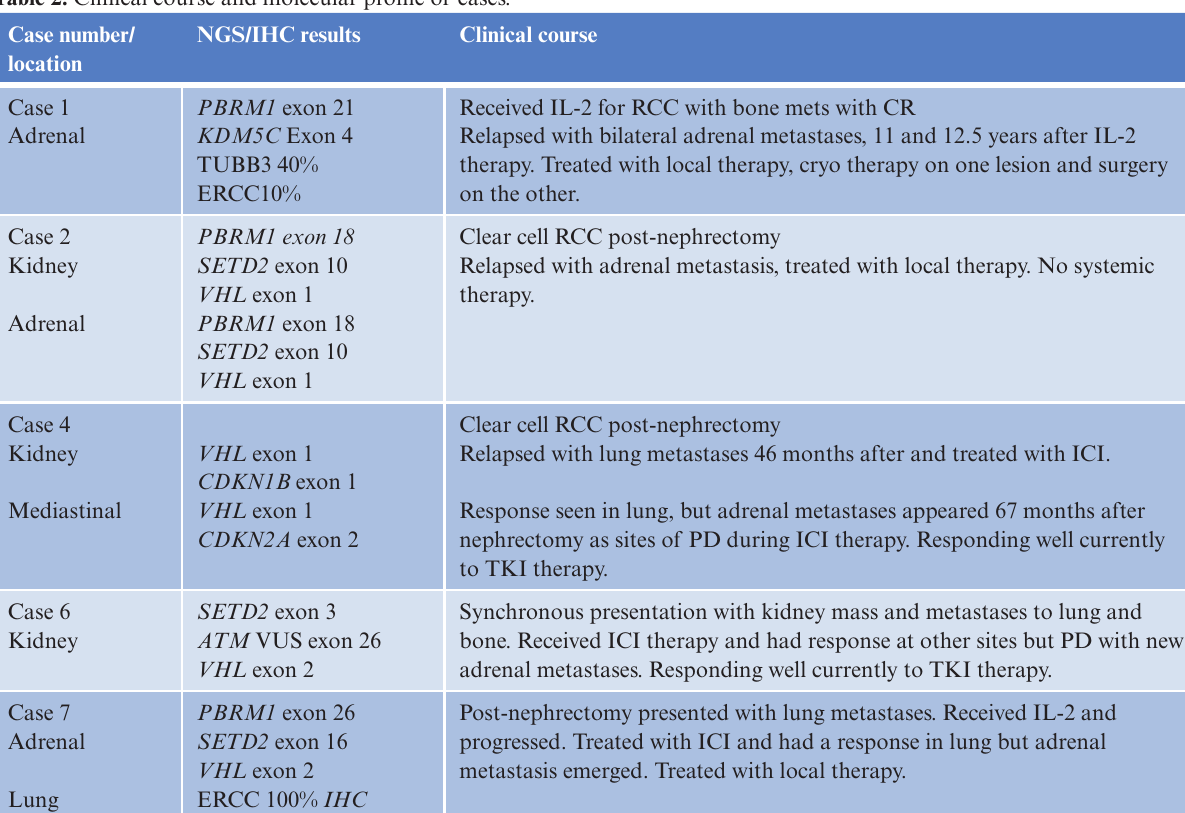
Table 2: Clinical course and molecular profile of